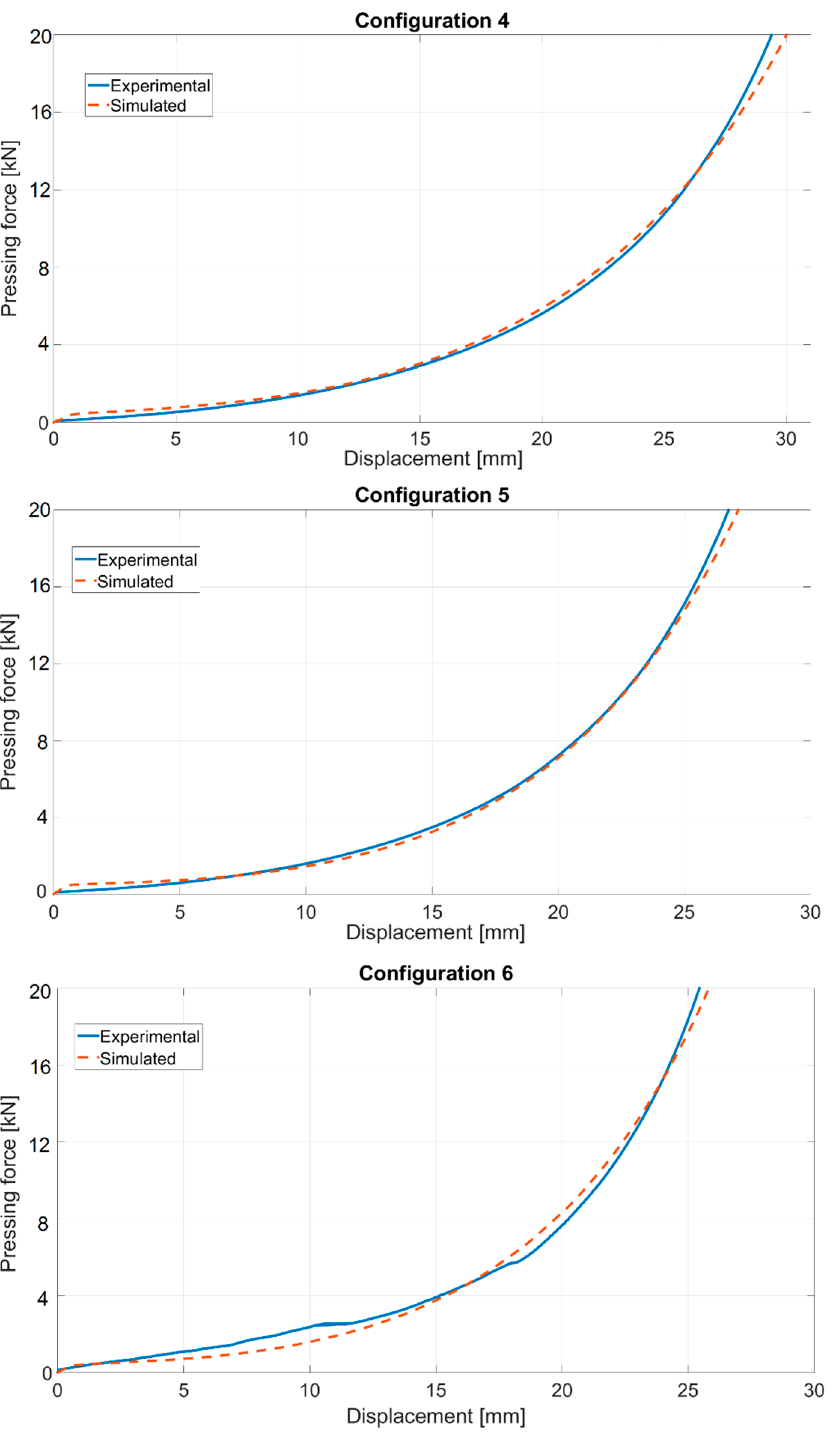
Figure 15. Force—displacement curves from three additional configurations (depicted in Figure